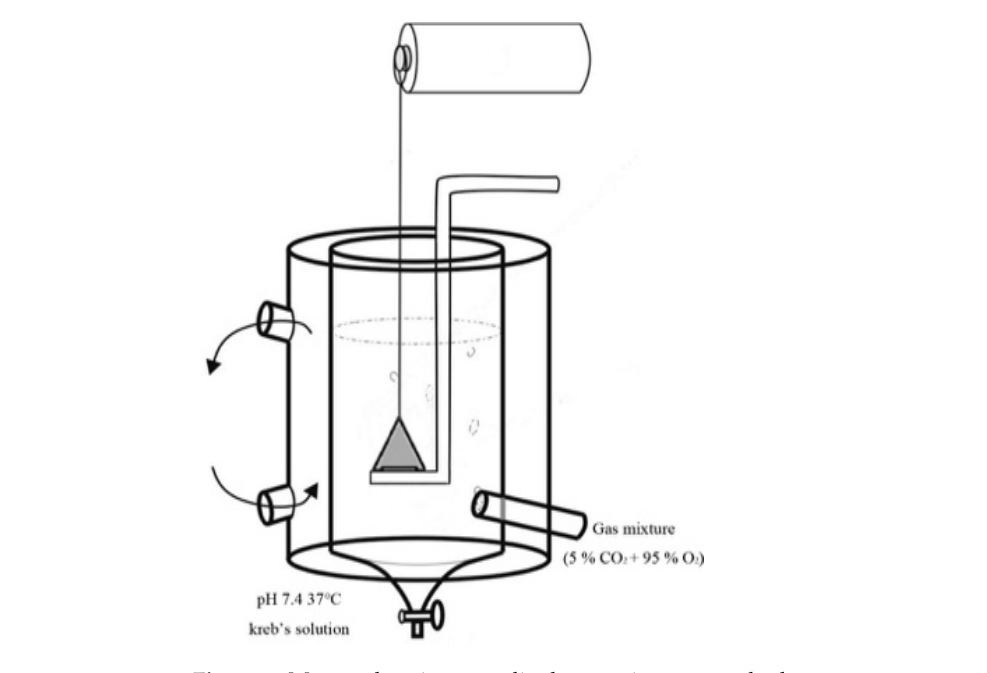
Figure 2. Mouse phrenic nerve-diaphragms in an organ